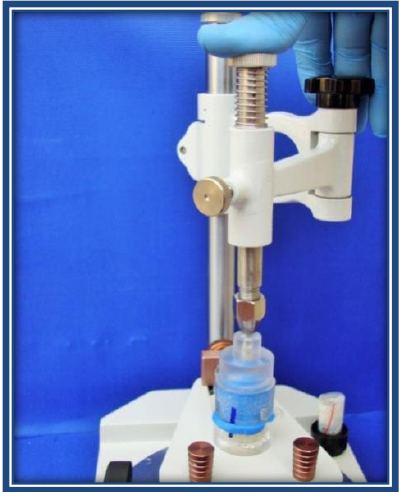
Figure 3: Impression making with dental